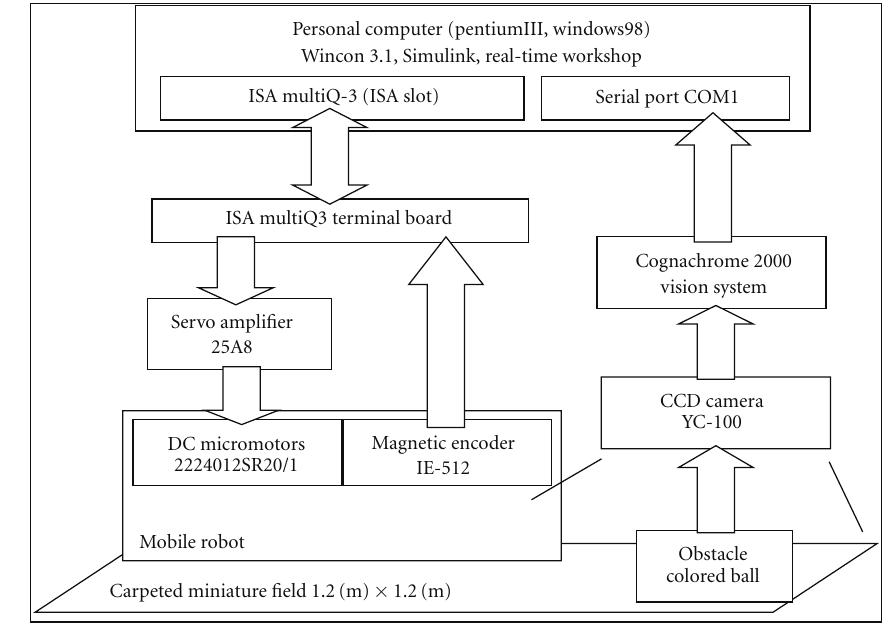
Figure 14: Hardware control diagram.